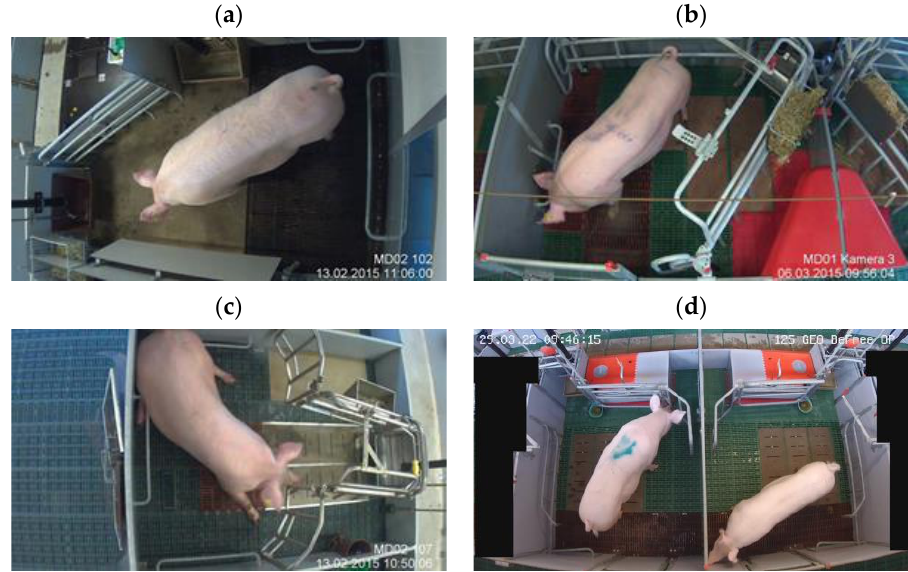
Figure 1. Farrowing pens with the possibility of temporary crating. ( a ) SWAP pen, ( b ) trapezoid pen, ( c ) wing pen, and ( d ) 2 BeFree pens.